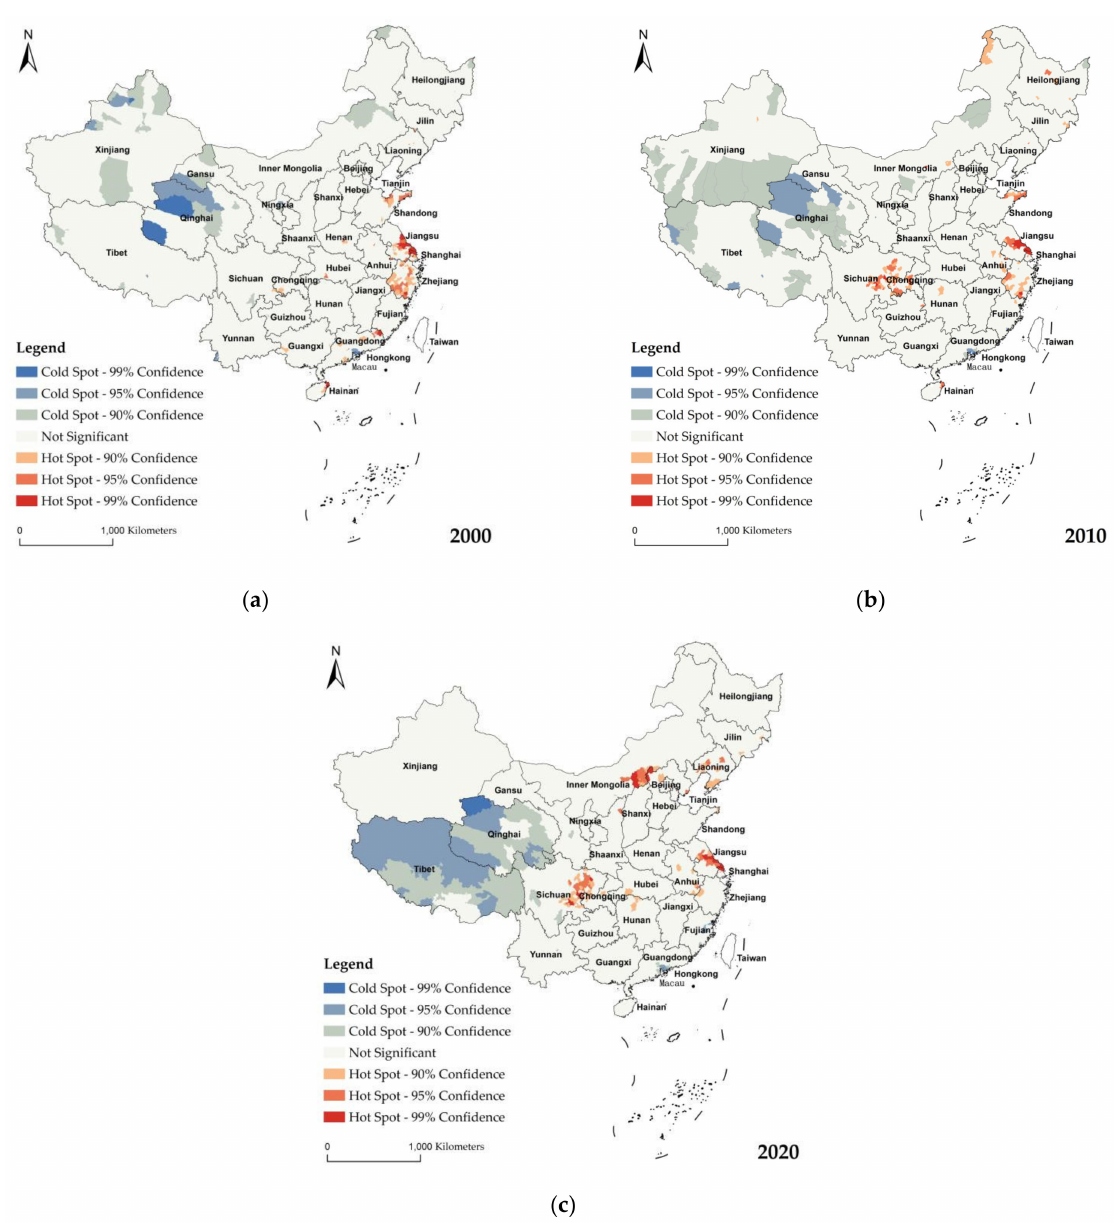
Figure 3. Spatial clustering (hot and cold spots) analysis of China’s rural population aging in 2000 ( a ), 2010 ( b ), and 2020 ( c ). In 2000, significant hot spots (high cluster) of RPA were spread around the Shandong, Zhejiang, Shanghai, and Jiangsu Provinces in the eastern area, and there were small hot spots in: Fujian in the eastern area; Guangdong, Guangxi, and Hainan in the southern area; Henan and Hubei in the central area; and Sichuan and Chongqing in Southwest China. Significant cold spots (low cluster) were mostly spread across Gansu, Xinjiang, and Qinghai in the northeast area, Inner Mongolia in the northern area, Tibet in the southwest, and the Pearl River Delta agglomeration of southern Guangdong in Southern